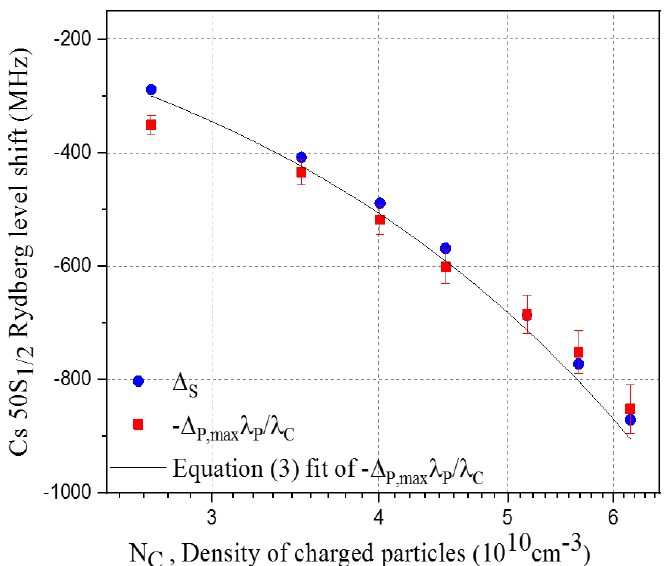
Figure 5. Comparison of the relationship between ∆ S and − ∆ P , max · λ P / λ C , where ∆ S is the calculated Rydberg level shift, − ∆ P , max · λ P / λ C is the detuning of the probe laser that produces the EIT signal of maximum intensity multiplied by the Doppler mismatch factor. The blue solid circles indicate the calculated Rydberg level shift versus N C for the Cs 50 S 1/2 Rydberg state, the red squares with error bars indicate the measured probe detuning multiplied by the Doppler mismatch factor versus N C for the Cs 50 S 1/2 Rydberg state. The solid black line is the fitting of Equation (3) to − ∆ P , max · λ P / λ C